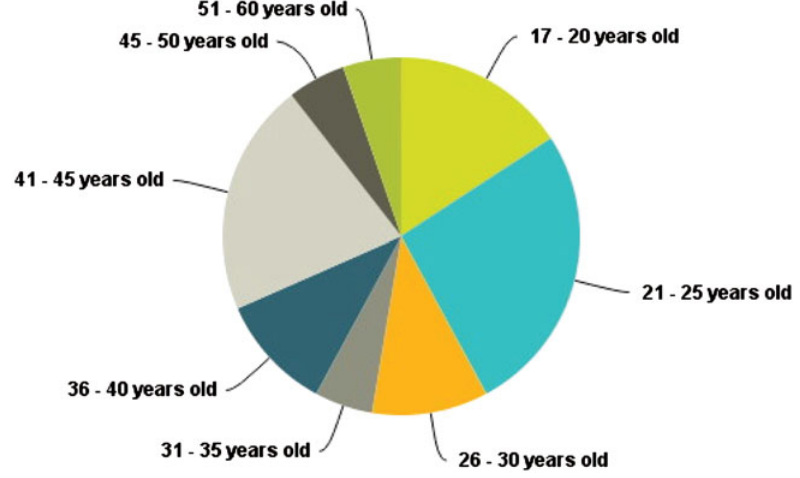
(Colour online) Survey participant